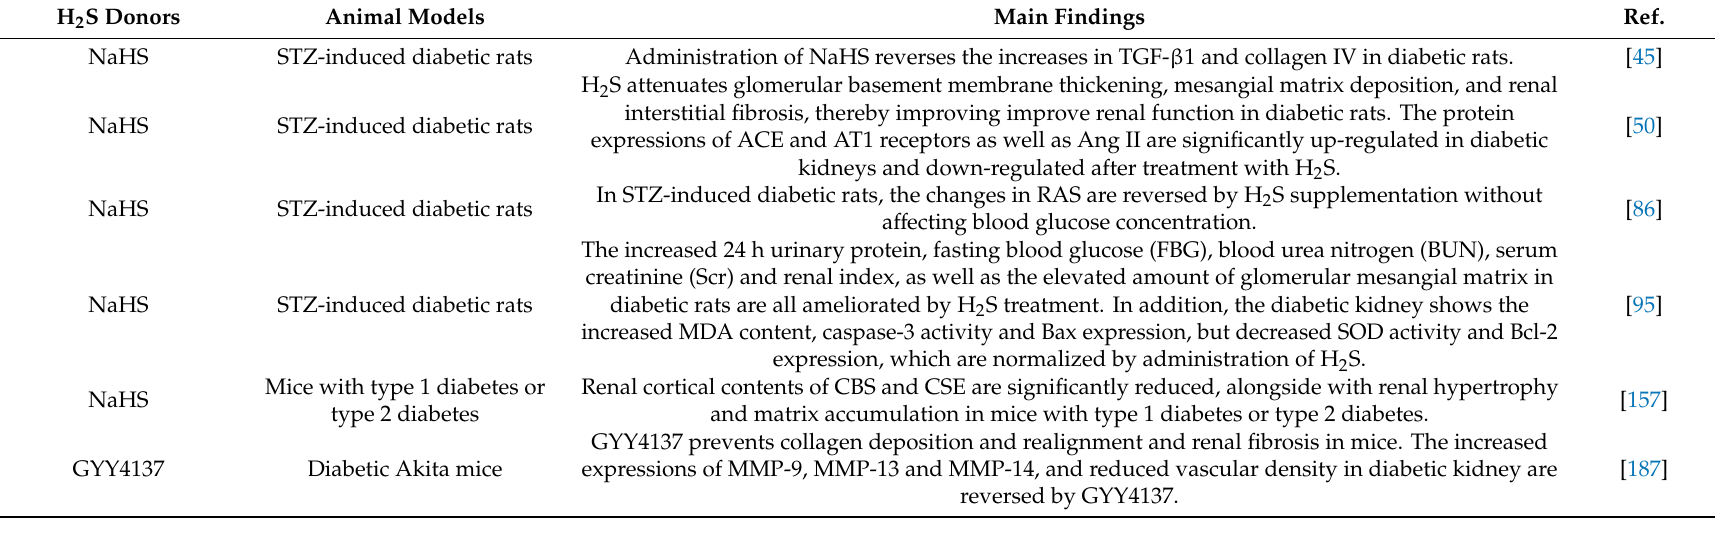
Table 2. Beneficial e ff ect of H 2 S on experimental diabetic nephropathy in vivo.